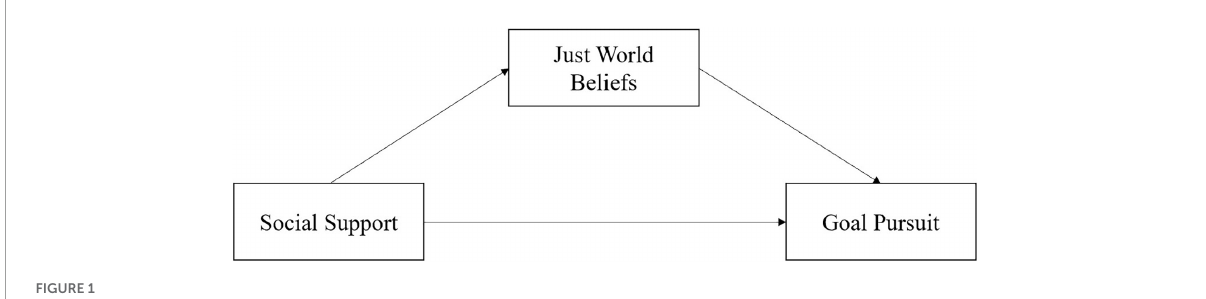
FIGURE1 Theoretical model